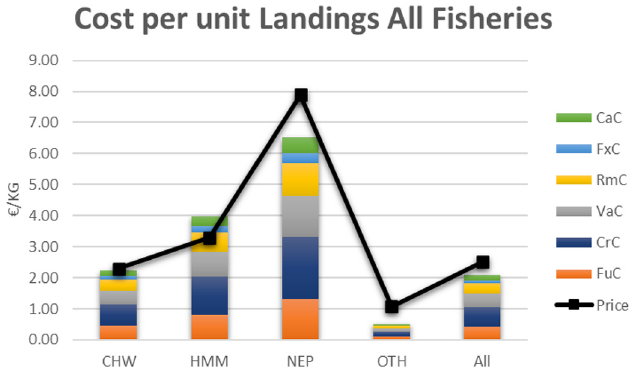
Fig. 7. Price and cost structure (fuel costs (FuC), other variable costs (VaC), crew costs (CrC), repair and maintenance costs (RmC), fi xed costs (FxC), capital costs (CaC)) of each fi shery (cod, haddock, whiting (cid:2) CHW; hake, monk fi sh, megrim (cid:2) HMM; nephrops